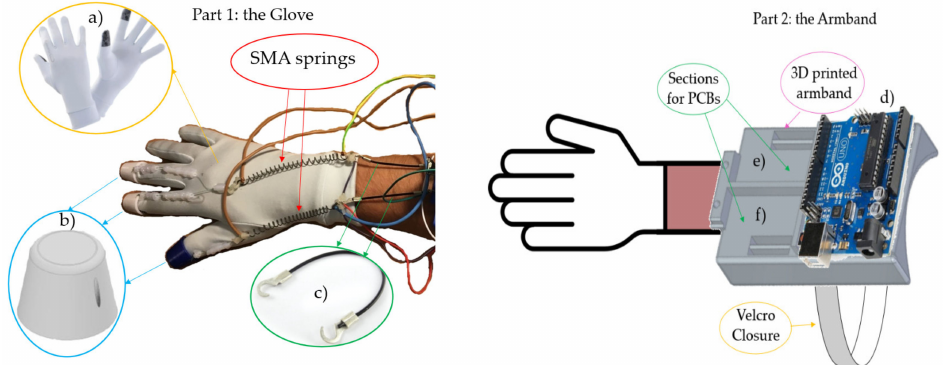
Figure 1. The two principal parts of the haptic glove. ( a ) Glove made of elastic fabric. ( b ) 3D printed finger cap ( c ) Flexible stretch sensors ( d ) Arduino UNO ( e ) electronic circuit for SMA control ( f ) electronic circuit for stretch